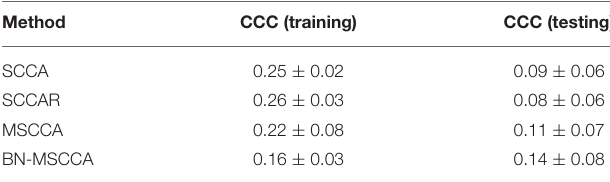
TABLE 2 | Comparison of CCCs on different methods (mean ± standard